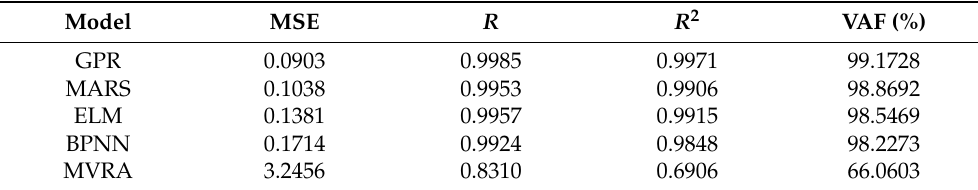
Table 11. PPV Prediction Results of Various